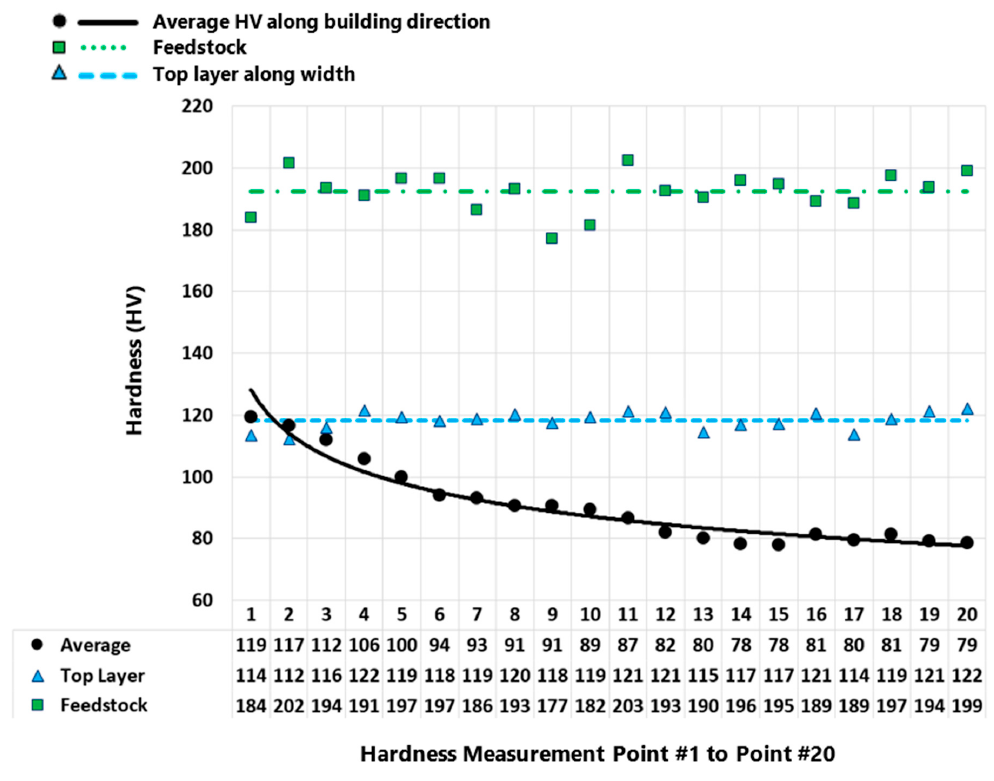
Figure 6. Microhardness results for the as-deposited Al2050 part and the feedstock.